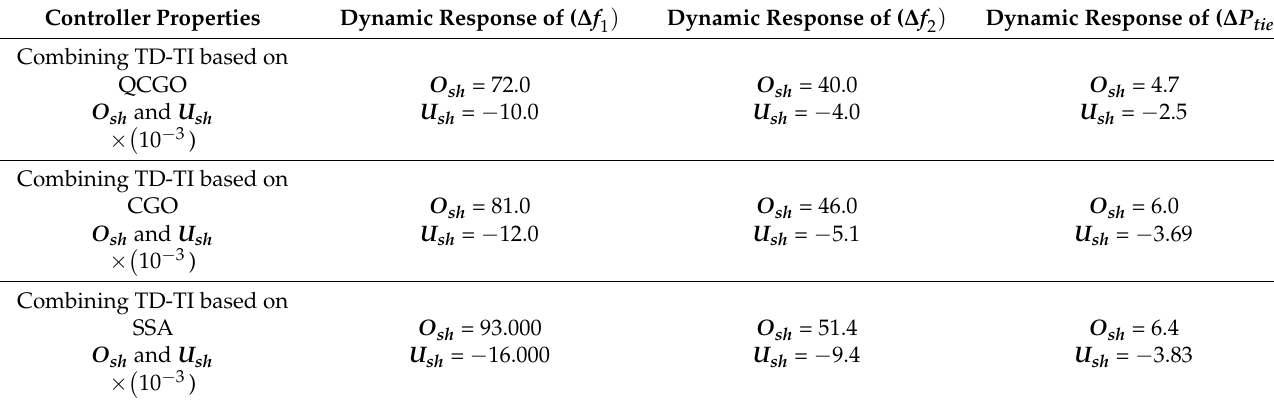
Table 20. The transient response specifications of the presented system for case